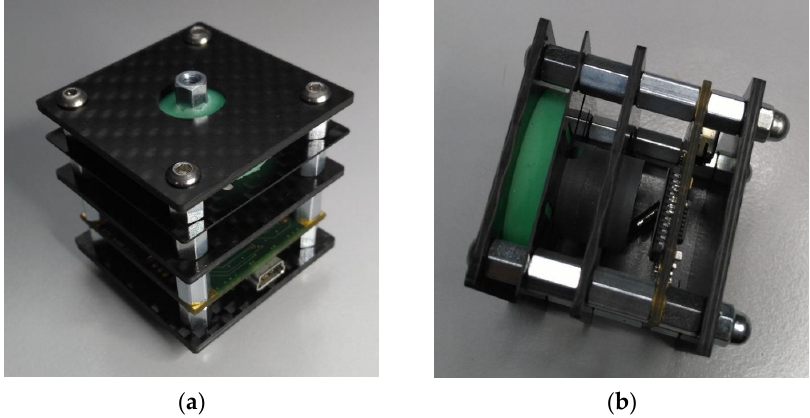
Figure 1. The 3-axis sensor version 3 prototype V12.2 carbon fiber-reinforced polymer (CFRP), ( a ) front view ( b ) side view.